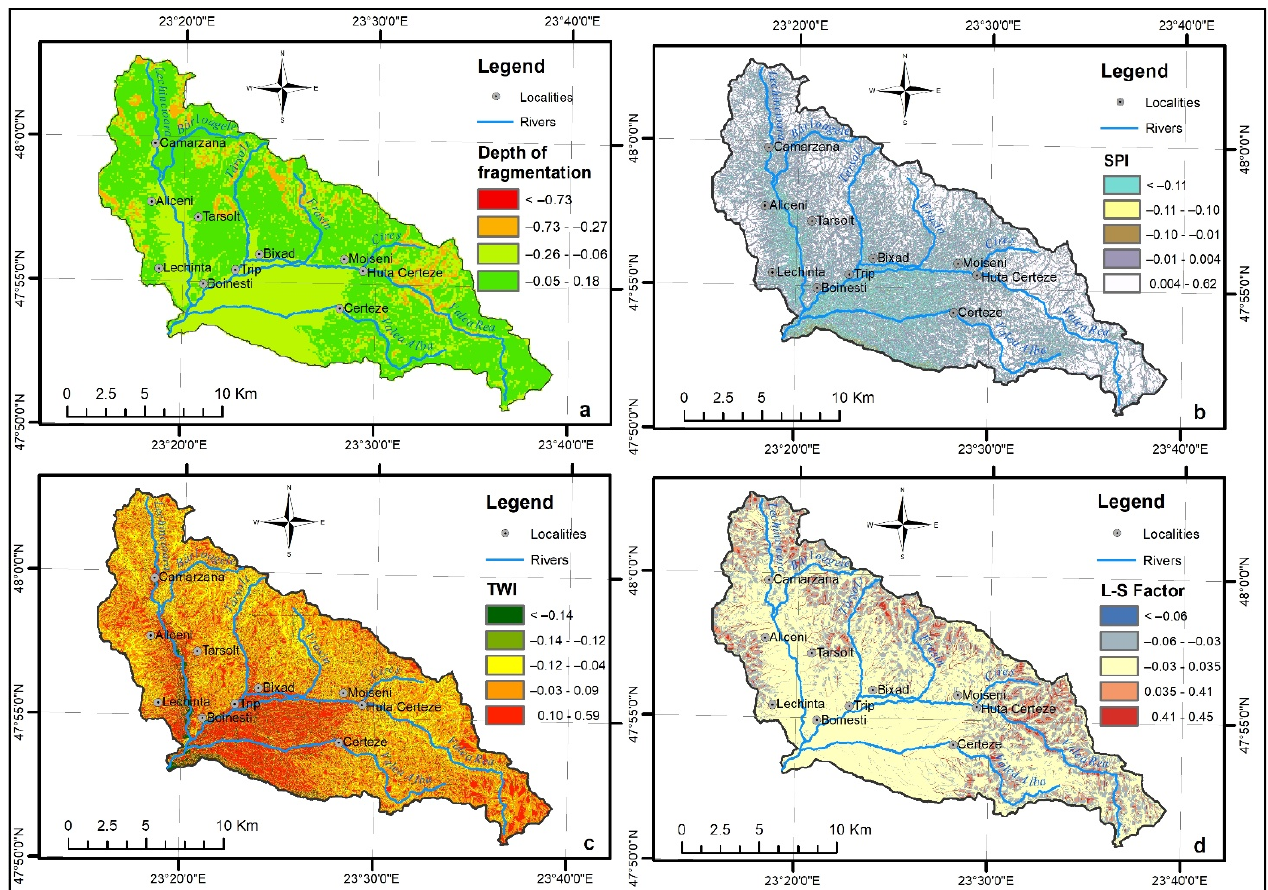
Figure 4. ( a ) Depth of fragmentation, ( b ) Stream Power Index, ( c ) Topographic Wetness Index, ( d ) L-S Factor.